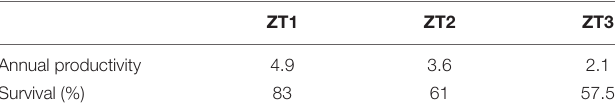
TABLE 4 | Variation in species composition between dates, zones and between dates and zones. Benthos cover GLM =